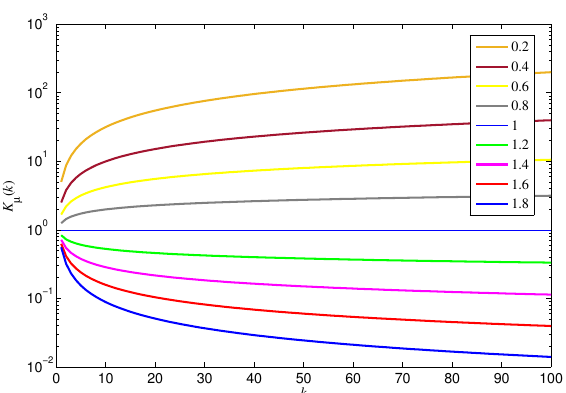
Figure 2. Curves of K µ ( k ) with different orders µ .